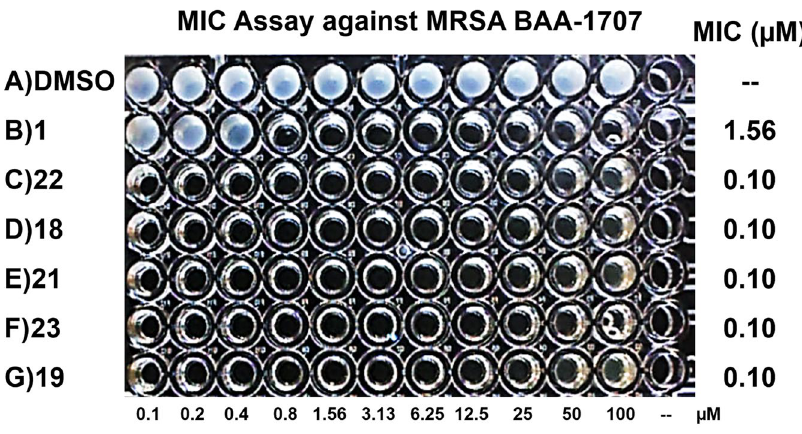
Figure 3. MIC assay results of potent new HPs (MIC = 0.10 µ M) against MRSA